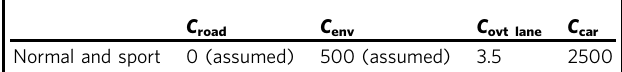
Table 3 Driving scene